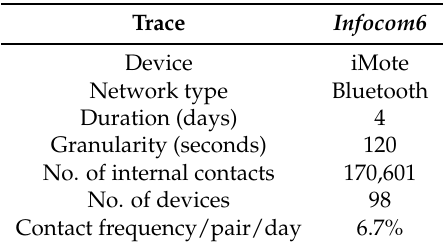
Table 1. Trace properties.